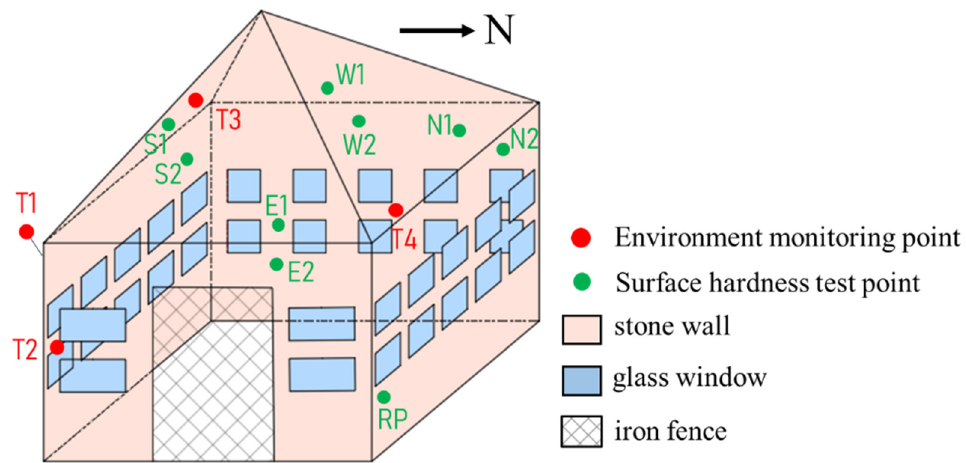
Figure 2. Distribution of detection points.